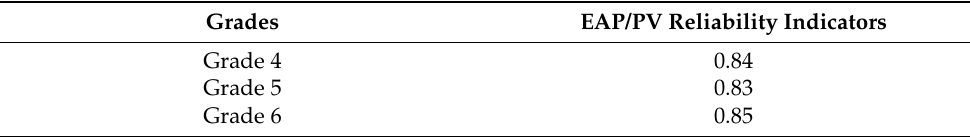
Table 11. EAP/PV reliability indicators by Grade.